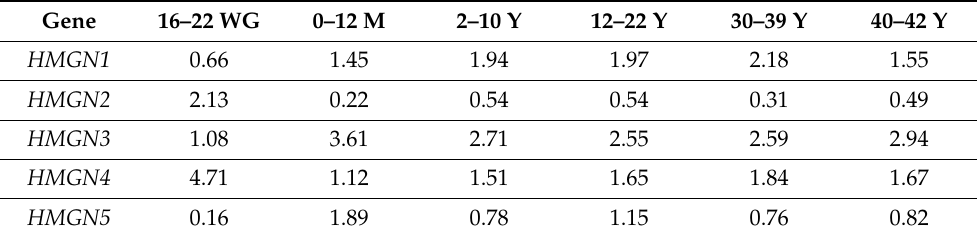
Table 3. Mean values of Z -ratio for the five human High-Mobility-Group Nucleosome-Binding (HMGN) genes expressed in different age ranks of the brain of human Down Syndrome (DS)